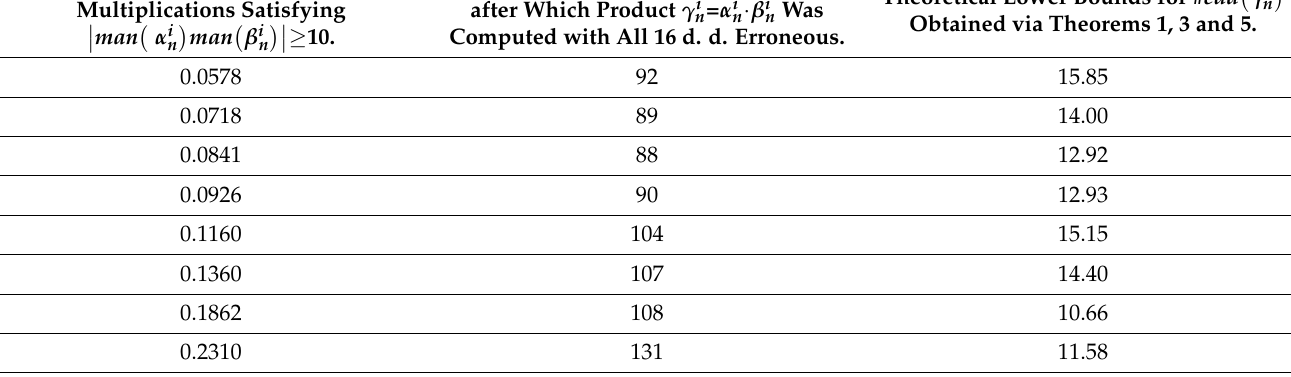
Table 7. F g is a percentage of multiplications in which inequality (3.16) holds. Thus, when F g < 50% holds, then γ i n becomes completely erroneous after a relatively small number of multiplications, in full accordance with the theoretical predictions. These predictions are based on the results of Theorems 1, 3 and 5, refer to the lower bound of the expected e. d. d. for each F g and they are presented in the last column for confidence level 1 − 10 − 5 . For each F g the experimental and theoretical results manifest an excellent